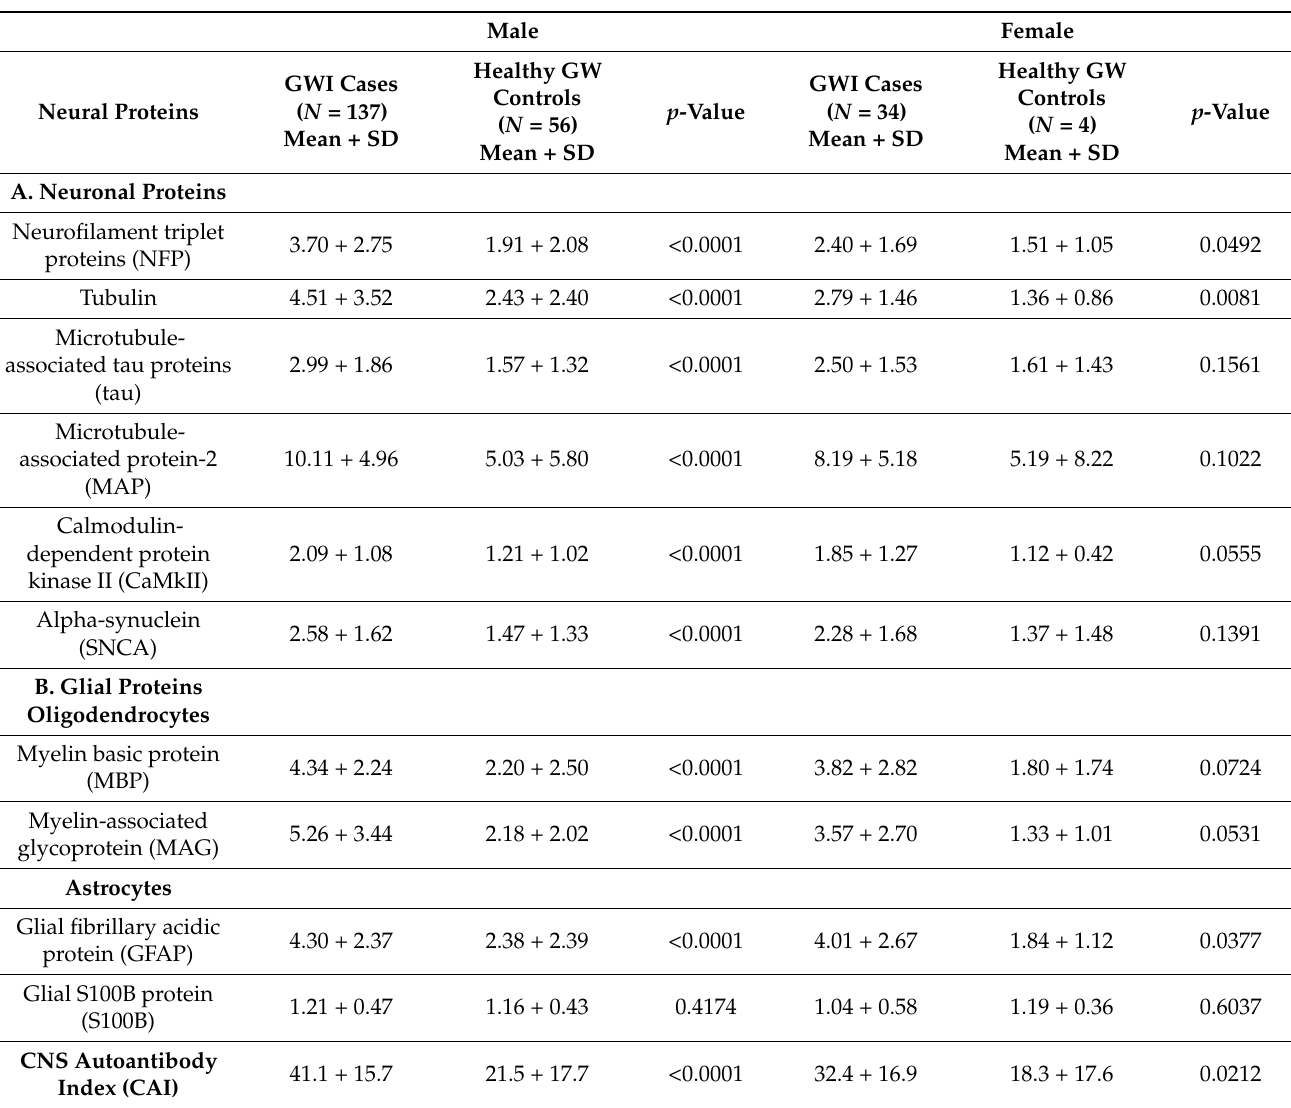
Table 3. Autoantibody ANCOVA analysis of GWI men and women compared to healthy Gulf War (GW) control men and women. Male Female